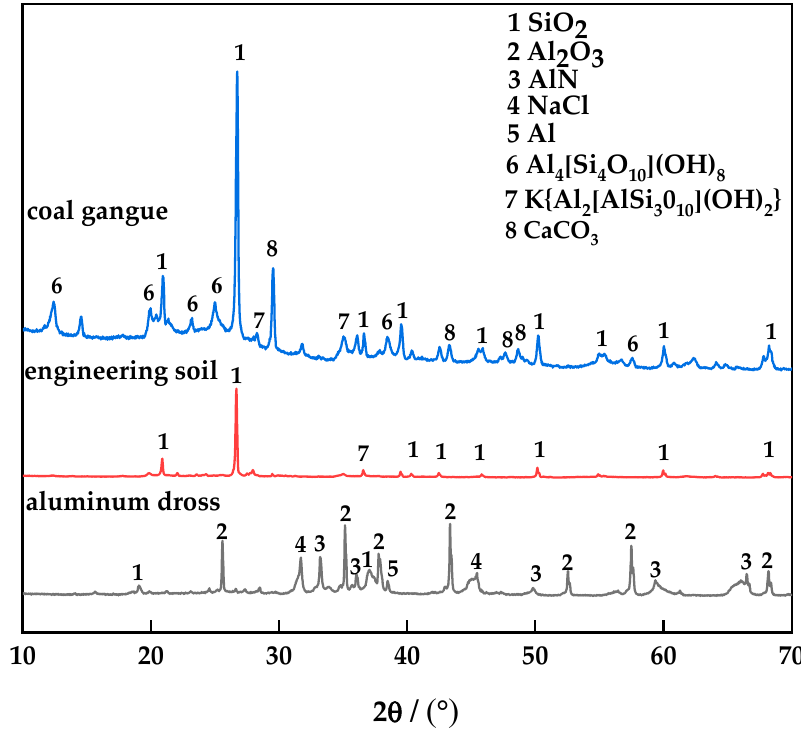
Figure 1. XRD pattern of the raw material.